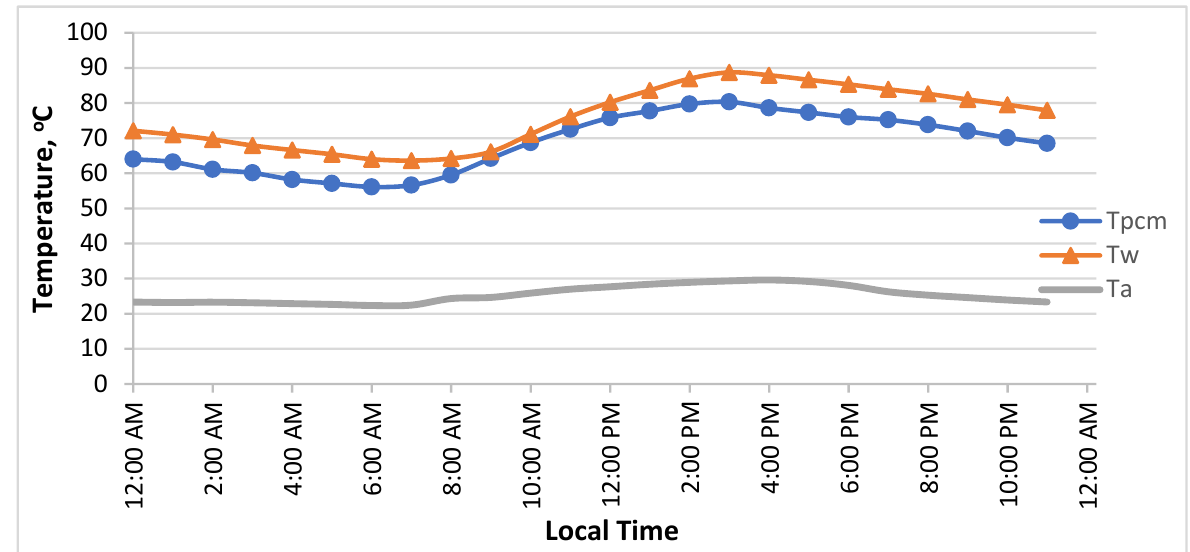
Figure 9. Temperature history of the system through no hot water consumption.